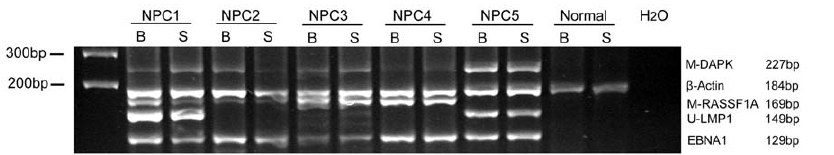
Figure 4. MMSP analysis of paired biopsies and swabs from NPC patients and noncancerous controls. Matched biopsies and swab samples from five NPC patients (NPC 1, 2, 3, 4 and 5) and one noncancerous control were showed as examples. Water was used as a blank control. B: